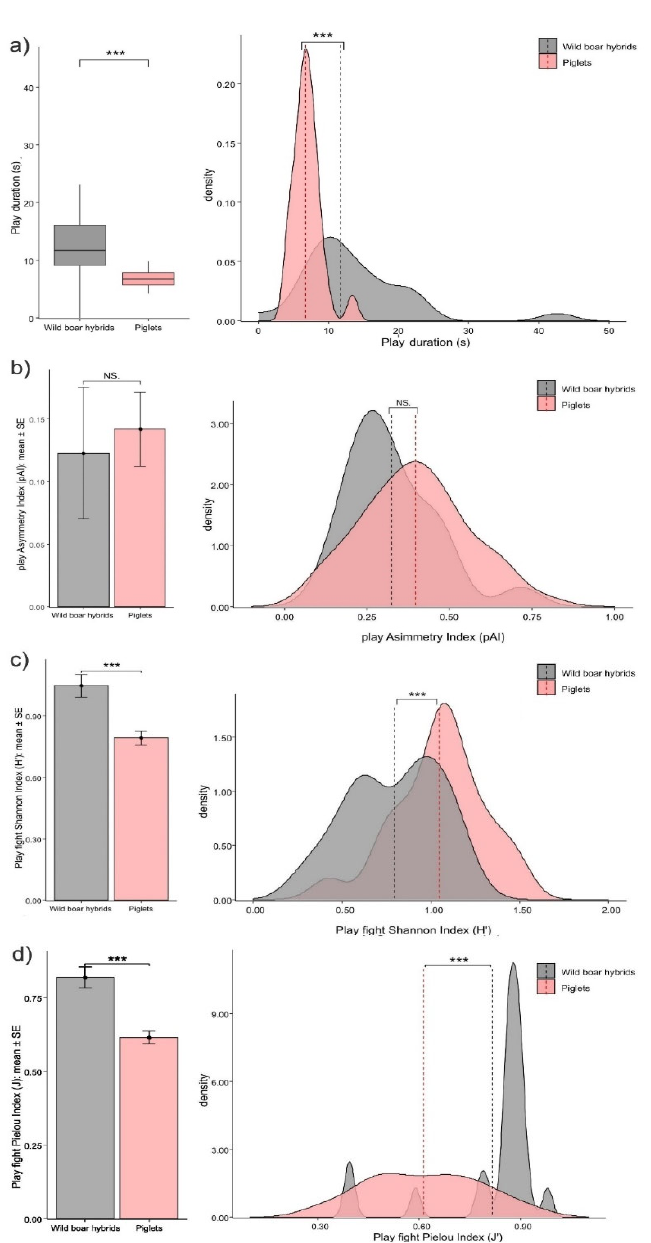
Figure 3. Differences in the duration of the play sessions between piglets and wild boar hybrids shown as bar plot (left) and density plot (right). ( a ) Piglets show shorter play sessions